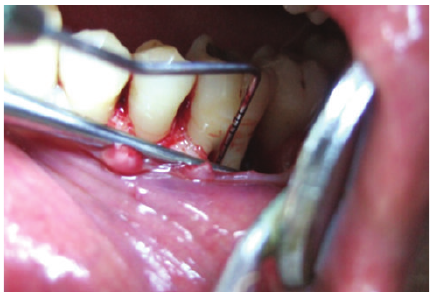
Figure 5: Evaluation of periodontal